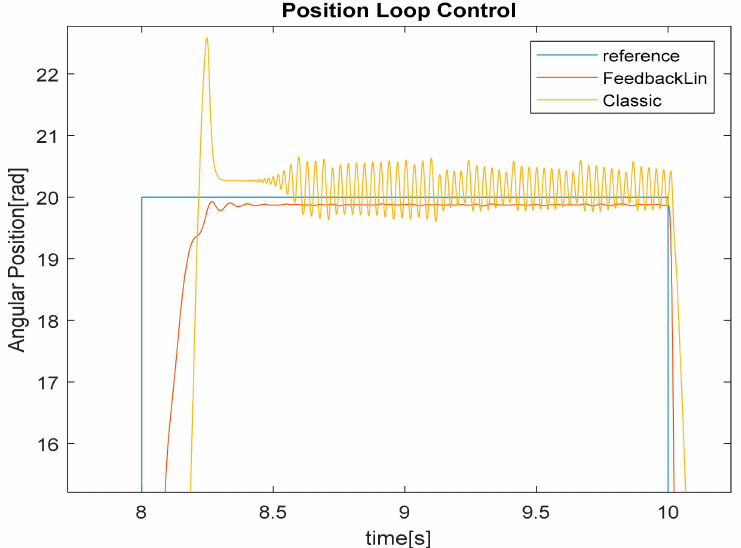
Figure 10. A detail of Figure 9 to highlight the ability of the nonlinear control to reduce the oscillation e ff ect due to the cogging torque.